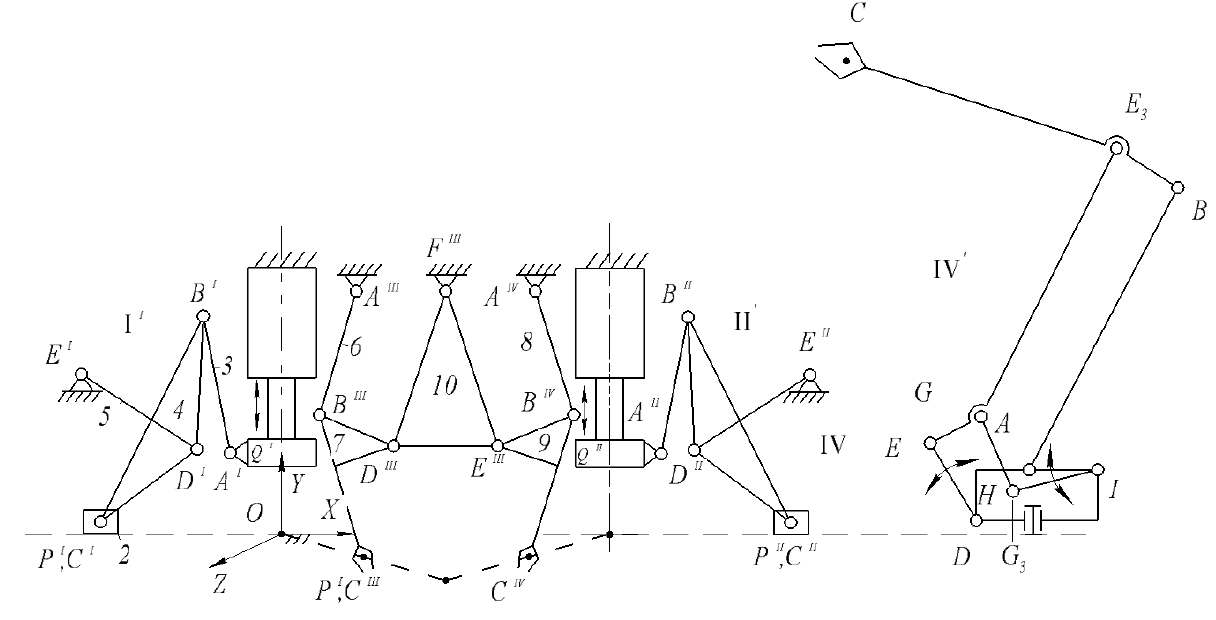
Figure 3. Structural scheme of the technological line with the RoboMech class